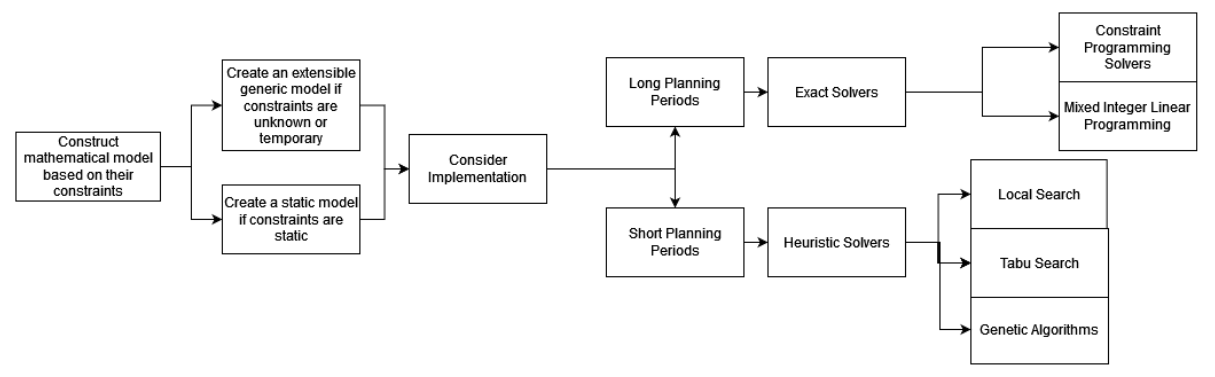
Figure 4. A flowchart of decisions to be made when choosing and implementing